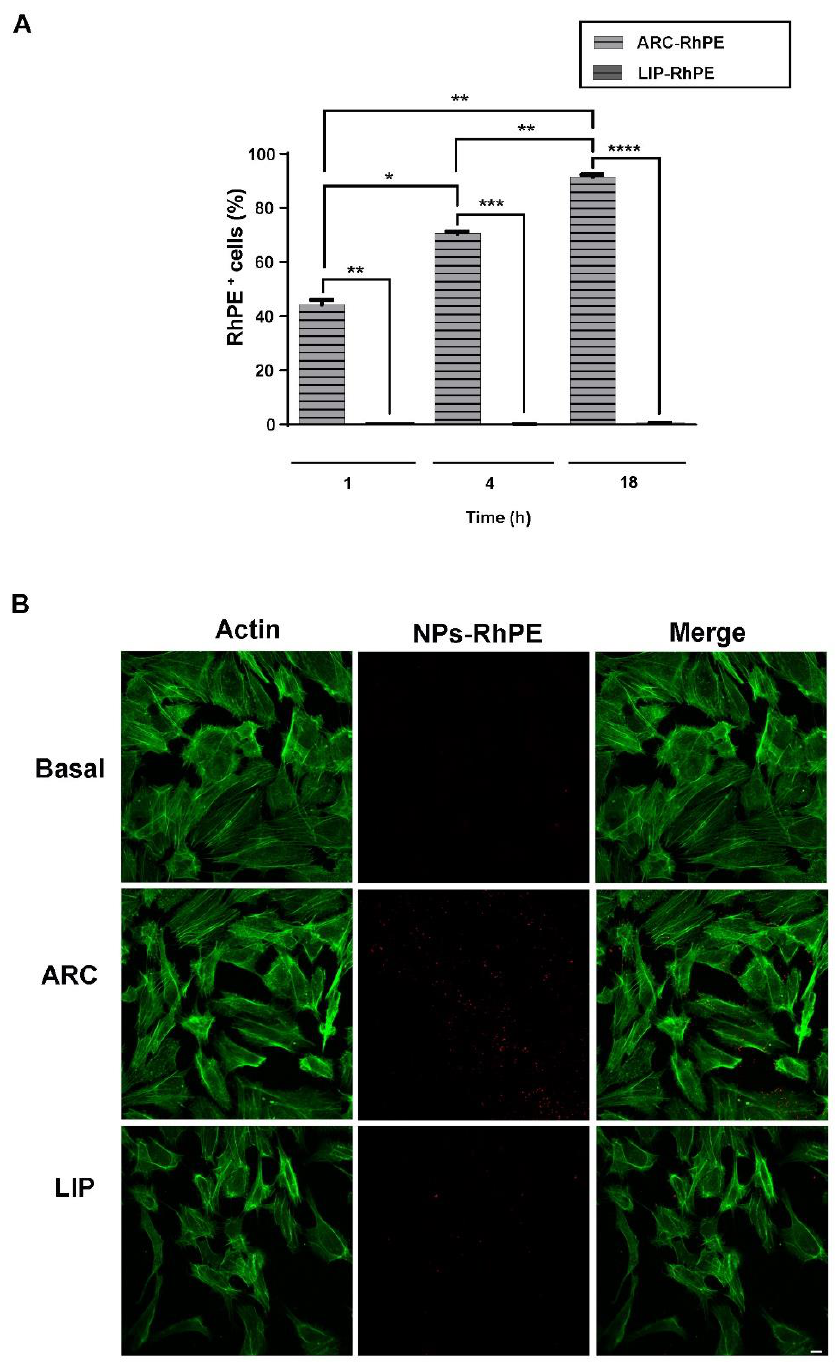
Figure 6. ARC are internalized by HUVEC. HUVEC were incubated for 1, 4 and 18 h with RhPE- labeled nanovesicles (ARC-RhPE and LIP-RhPE). Uptake assays were performed by ( A ) flow cy- tometry (one-way ANOVA followed by Bonferroni multiple comparisons test; * p < 0.05, ** p < 0.01, *** p < 0.01 and **** p < 0.001 between the labeled groups) and ( B ) Confocal microscopy. Representa- tive images show RhPE-nanovesicles (red) and cytoplasm (green, FITC-phalloidin staining). Scale bars: 10 μm.